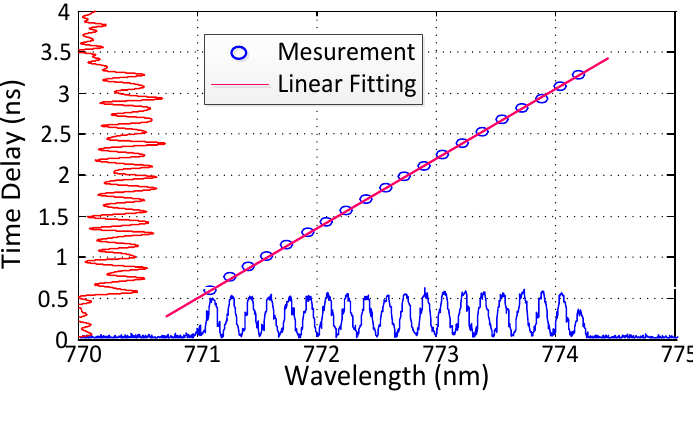
Figure 2. Group delay response of the linearly chirped fiber Bragg grating (LCFBG) operating at 800 nm. One-to-one wavelength-to-time mapping verifies the Dispersive Fourier transformation (DFT) at 800 nm band